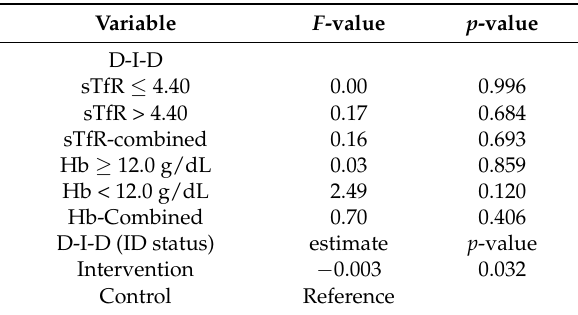
Table 2. Endpoint comparison of iron status among childbearing age women (15–49 years) in intervention and control